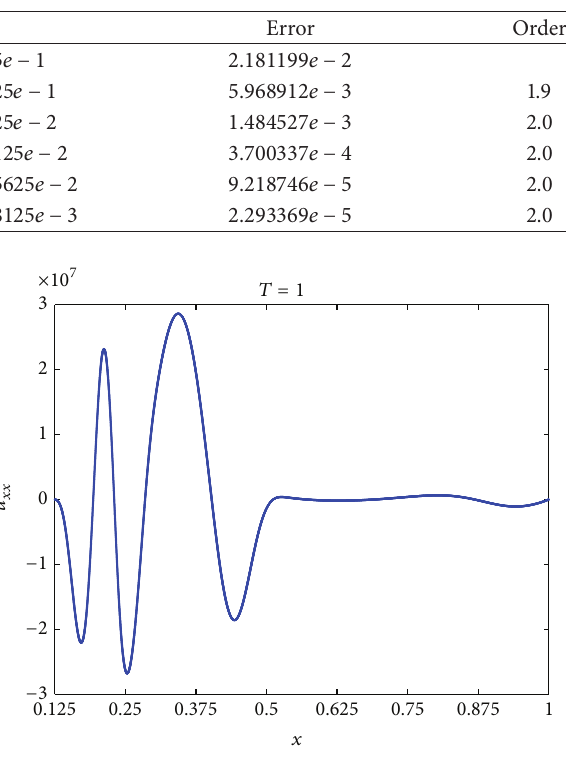
Figure 1: Test Problem 1. Approximated second derivative of 𝑢